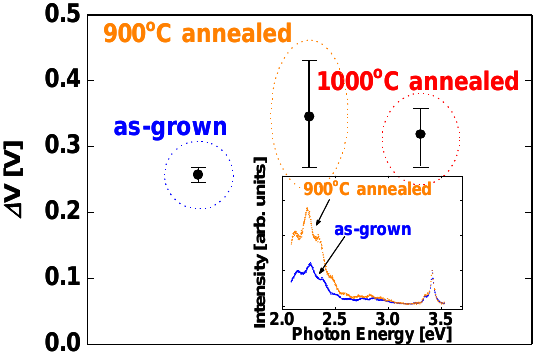
Figure 3. The sensitivity of Pt – (undoped) GaN Shottky diodes for 1% H temperature as a function of the annealing temperature of the GaN surfaces. The sensitivity is defined as a shift of voltage upon exposure to 1% H current of 0.1 nA. The inset shows the room temperature photoluminescence spectra of as-grown and 900 °C annealed GaN